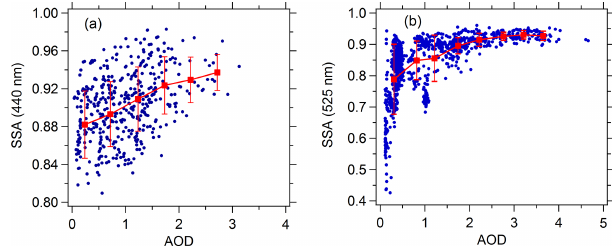
Figure 6. Correlation between SSA and AOD (380nm). (a) SSA (440nm) is acquired from AERONET during 2012–2015. (b) SSA (525nm) is acquired from the near-ground measurement campaign in August 2012.